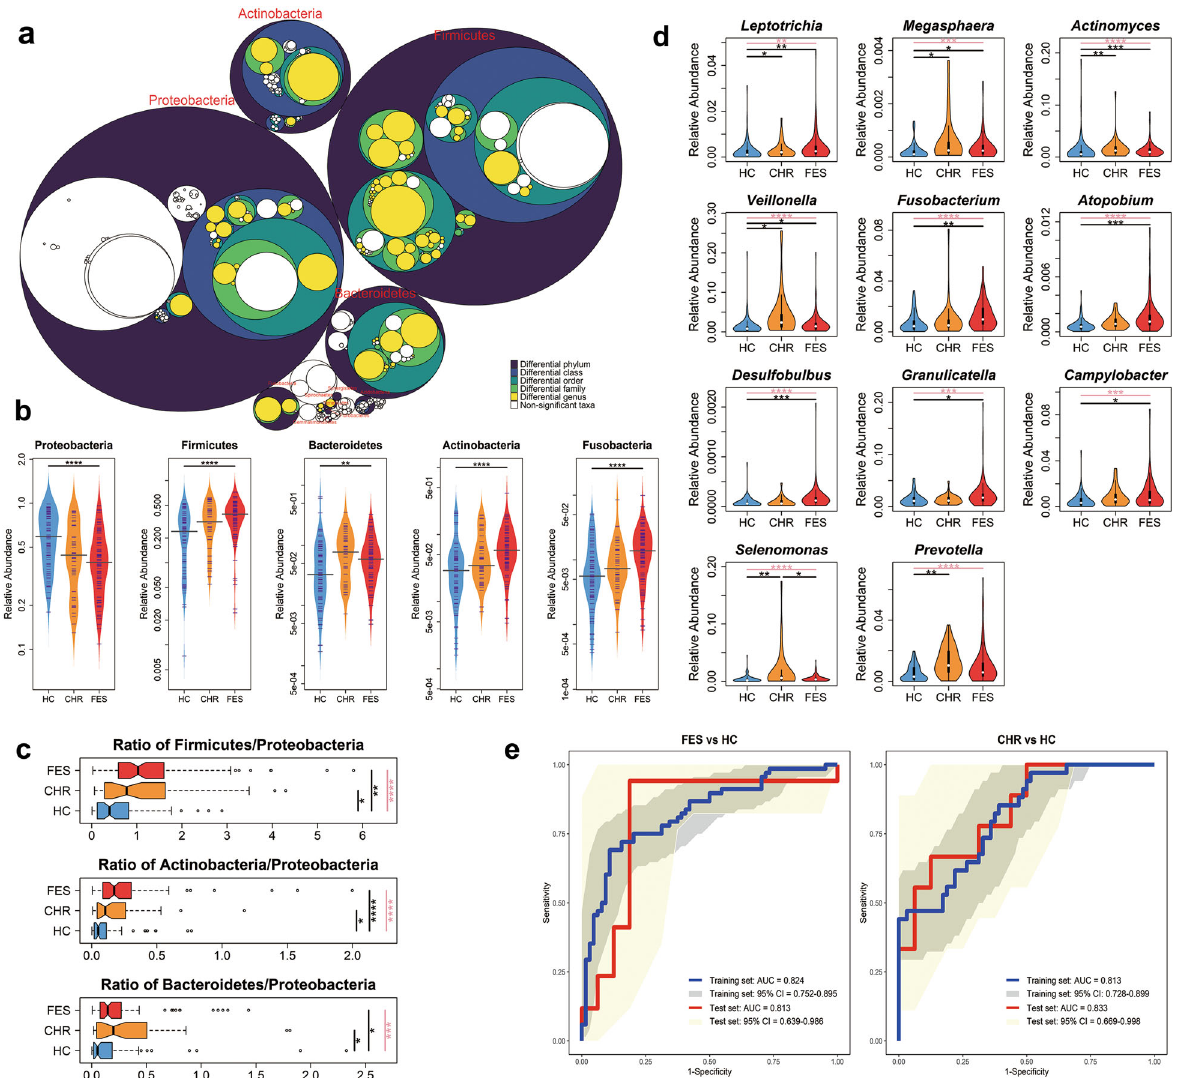
Fig. 2 Differential abundances of salivary bacterial communities during initiation of schizophrenia. a Differentially abundant taxa between the FES, CHR, and HC groups are colored. The largest circles represent the phylum level, and the inner circles represent class, order, family, and genus. b The leading fi ve abundant phyla differed in abundances among the three groups. Center lines of bean plots represent median values. c The ratios of Firmicutes/Proteobacteria, Actinobacteria/Proteobacteria, and Bacteroidetes/Proteobacteria were higher in FES and CHR patients than in HCs. Center lines of box plots show median values, box hinges indicate fi rst and third quartiles, and whisker represent the furthest data points within 1.5 interquartile ranges of the hinges. d H 2 S-producing bacteria were enriched in either the FES or the CHR group than in HCs. e Receiver operating characteristic (ROC) curves for the logistic regression models. The area under the curve (AUC) values for distinguishing FES from HCs in the training and test sets were 0.824 (sensitivity: 0.691; speci fi city: 0.891) and 0.813 (sensitivity: 0.941; speci fi city: 0.813), respectively. AUCs for distinguishing CHR from HCs in the training and test sets were 0.813 (sensitivity: 0.853; speci fi city: 0.609) and 0.833 (sensitivity: 0.667; speci fi city: 0.875), respectively. The comparisons among the three groups were performed by the Kruskal – Wallis test and the q values were corrected with FDR; the comparisons between the two groups were conducted by the quantile regression, adjusting for age, gender and education level and correcting with FDR. * q < 0.05; ** q < 0.01; *** q < 0.001; **** q < 0.0001. Pink lines represent comparisons among the three